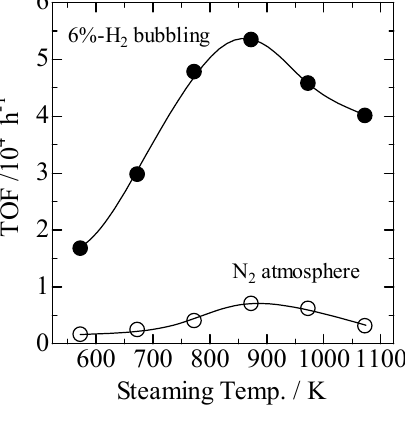
Figure 5. Turnover frequencies plotted as a function of the steaming temperature in the reaction between bromobenzene and styrene. Catalyst, Pd/USY. 6%-H applied during reactions.